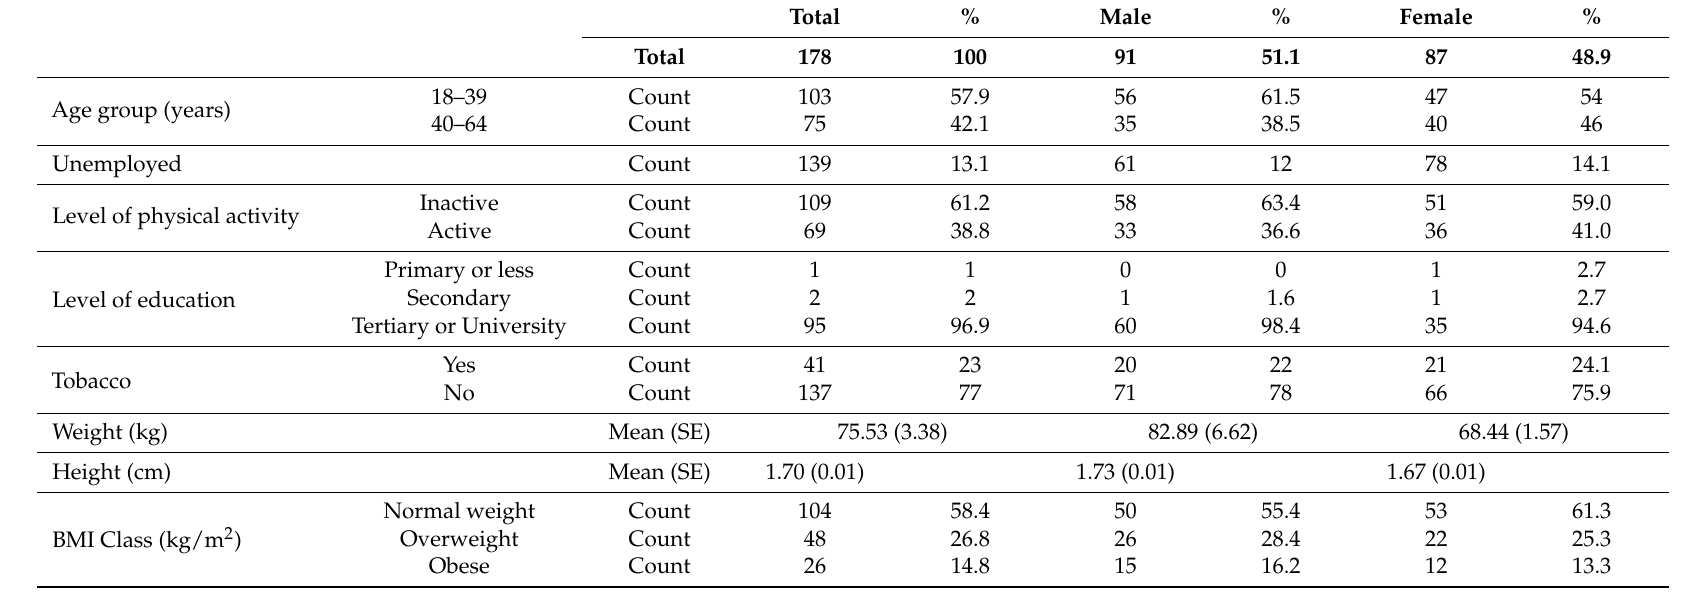
Table 5. Descriptive characteristics of subjects that completed seven-day diaries ( n =